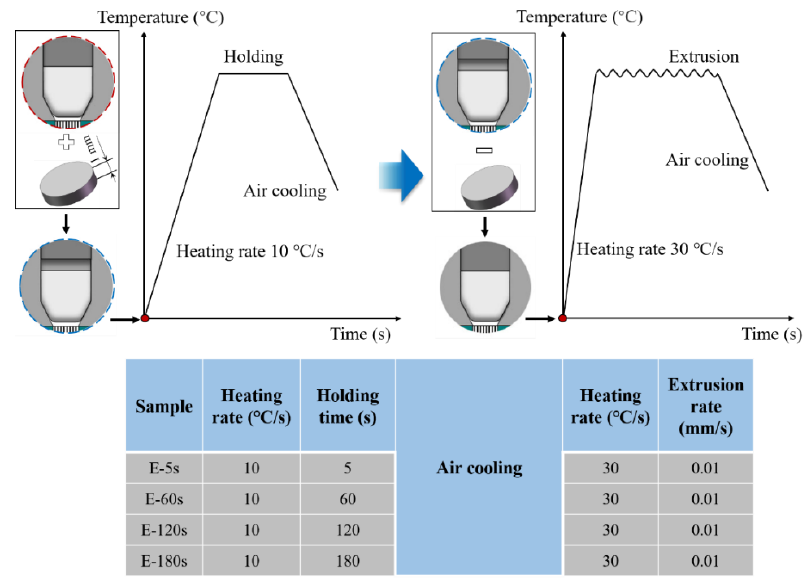
Figure 9. Schematic illustration of the extrusion processing routes for the same carburizing condition with different β grains.